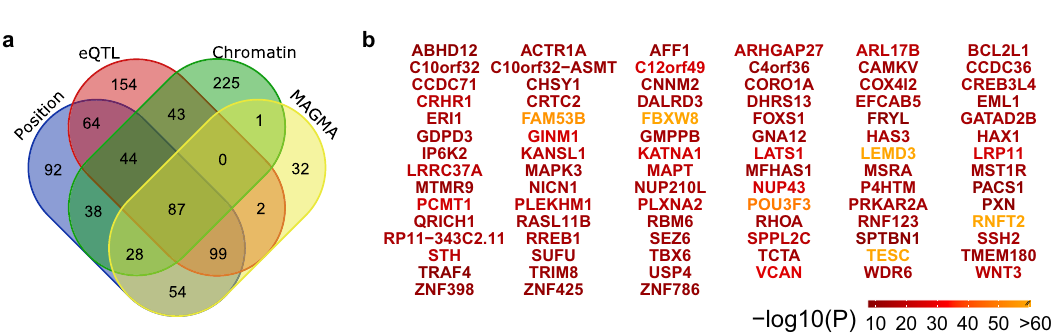
Fig. 2 Gene mapping of the 177 loci associated with the hippocampal formation implied 87 genes by all mapping strategies. a Venn diagram showing number of genes mapped by the four different strategies. b The 87 genes implied by all four strategies with colour-coded − log 10 ( P ) statistics from the multivariate ( P Bonf = 9.2 × 10 − 8 ), regulation of anatomical structure morpho-